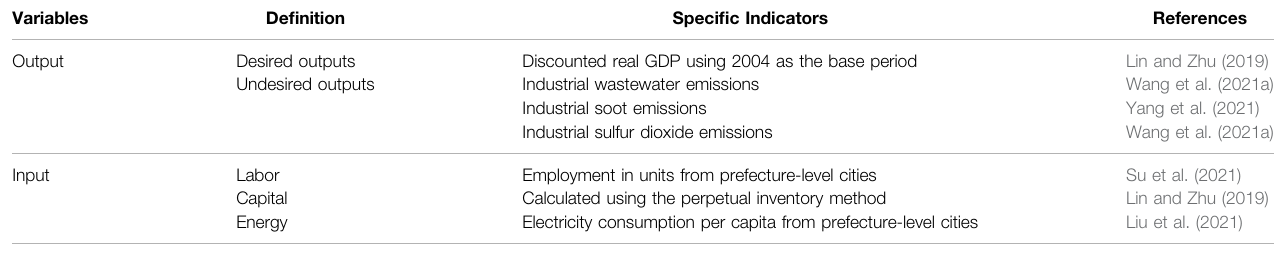
TABLE 1 | Green economic growth indicator construction system.